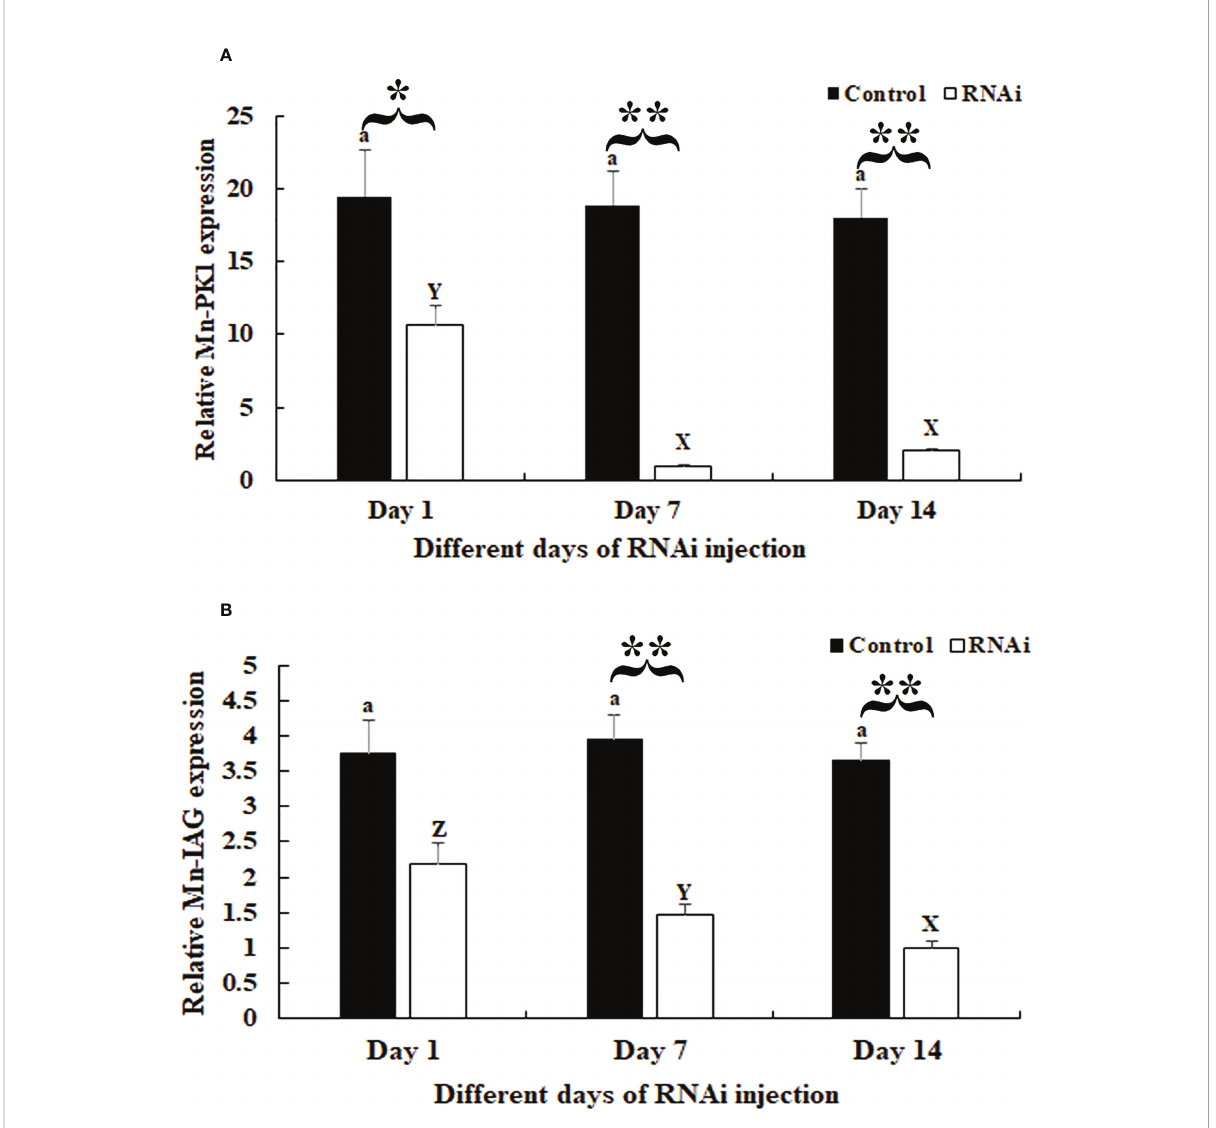
FIGURE 6 Measurement of Mn-Plk1 and Mn-IAG expression at different days after dsPlk1 and dsGFP injection . The amount of Mn-Plk1 and Mn-IAG mRNA was normalized to the EIF transcript level. Data are shown as mean ± SD (standard deviation) of tissues from three separate individuals. Lowercases (a and b) on the bars indicate the expression differences between different days in the dsGFP injected prawns, while capital letters (X, Y and Z) on the bars indicate expression differences between different days in the dsPlk1 prawns (ANOVA). *( P < 0.05) and **( P < 0.01) indicates signi fi cant expression difference between the RNAi group and control group at the sample day (independent sample T-test). (A) Measurement of Mn-Plk1 expression at different days after dsGFP and dsPlk1 injection. (B) Measurement of Mn - IAG expression at different days after dsGFP and dsPlk1